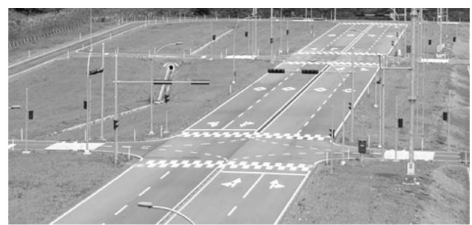
Figure 7. Vehicle-road connection test intersection.